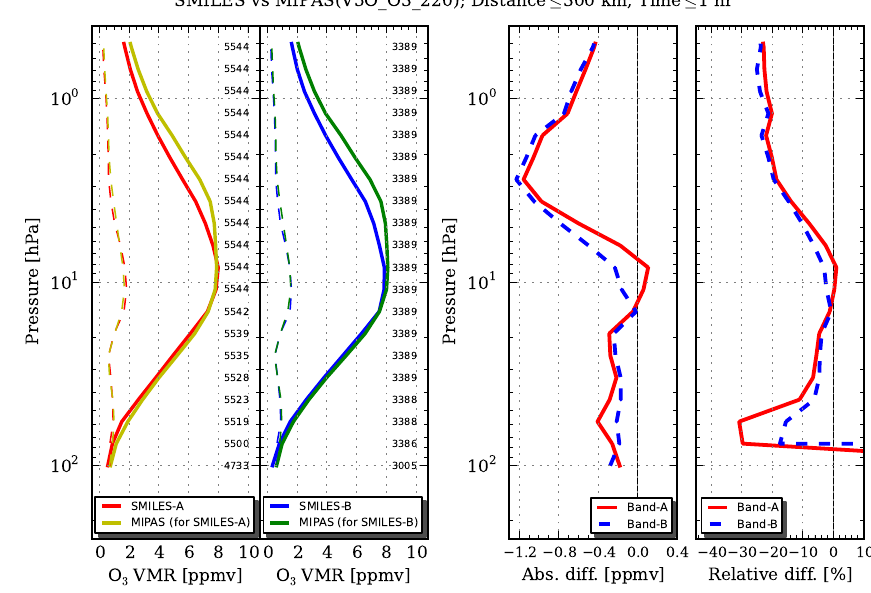
Fig. 18. Same with Fig. 17 but using MIPAS V5O_O3_220 dataset.